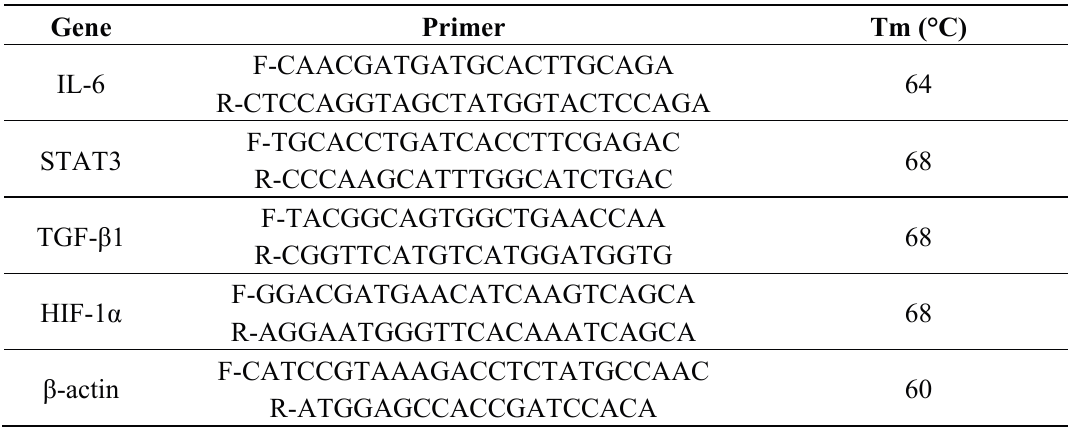
Table 1. Primers used for real-time RT-PCR analysis of gene